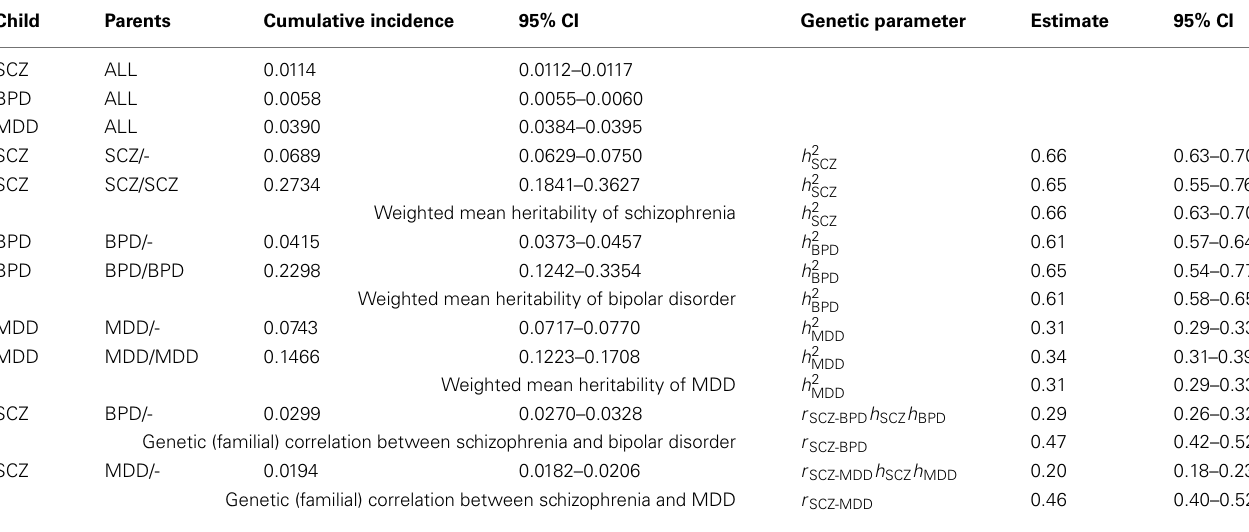
TableA1 | Estimates of genetic parameters using cumulative incidences to age 51 estimated from national records of the Danish